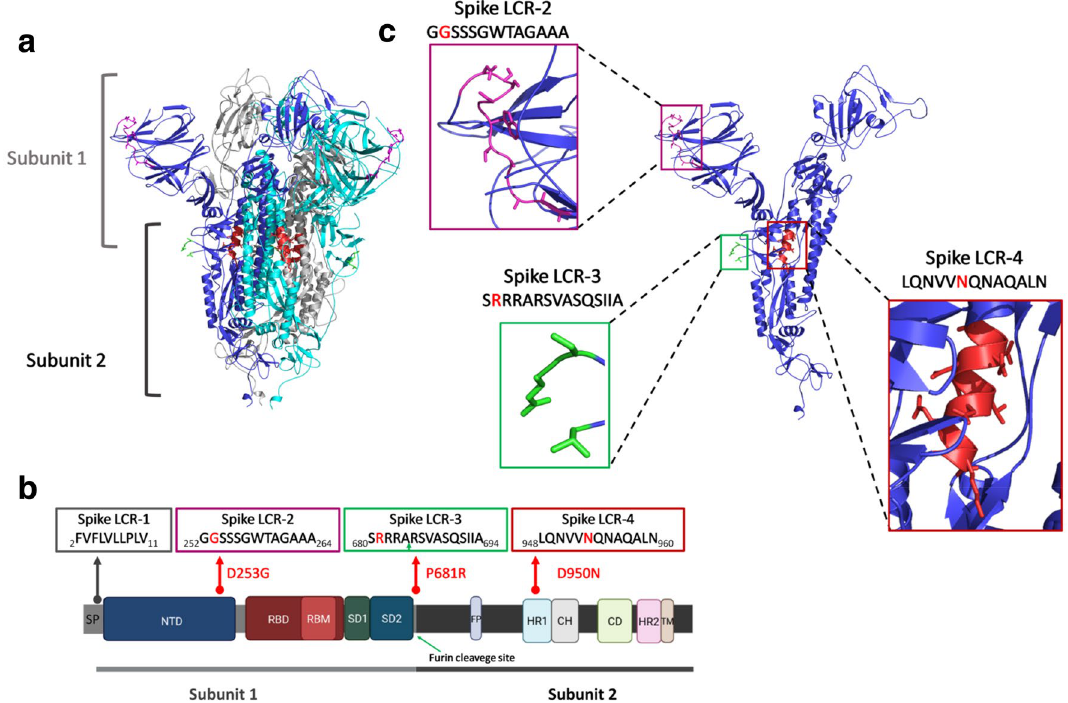
Figure 3. ( a ) The SARS-CoV-2 spike protein three-dimensional structure (by cryo-electron microscopy 24 , PDB code: 7BNM). The structure corresponds to a trimer, where each monomer is represented with a different color. The two subunits that make up each monomer (Subunit 1, also known as Head region, and Subunit 2, or the Stalk region) are indicated. ( b ) Domain organization of the spike protein. The position of each of the LCRs found in this work, together with the mutations present in each variant spike protein are shown. The position of the signal peptide (SP) and Spike LCR-1 are indicated. The green arrow in the Spike LCR-3 box indicates the furin cleavage site. ( c ) Monomer of the spike protein. Close ups of each of the structural regions corresponding to the different LCRs are shown in colored boxes. The sequences of each LCR are represented, with the mutations indicated with a red letter. Protein structures in panels a and c were rendered using PyMOL (The PyMOL Molecular Graphics System, Version 2.0 Schrödinger, LLC.). Panel b was created with BioRender.com. Abbreviations: SP, signal peptide; NTD, N-terminal domain; RBD, receptor-binding domain; RBM, receptor- binding motif; SD1, subdomain 1; SD2, subdomain 2; FP, fusion peptide; HR1, heptad repeat 1; CH, central helix; CD, connector domain; HR2, heptad repeat 2; TM, transmembrane